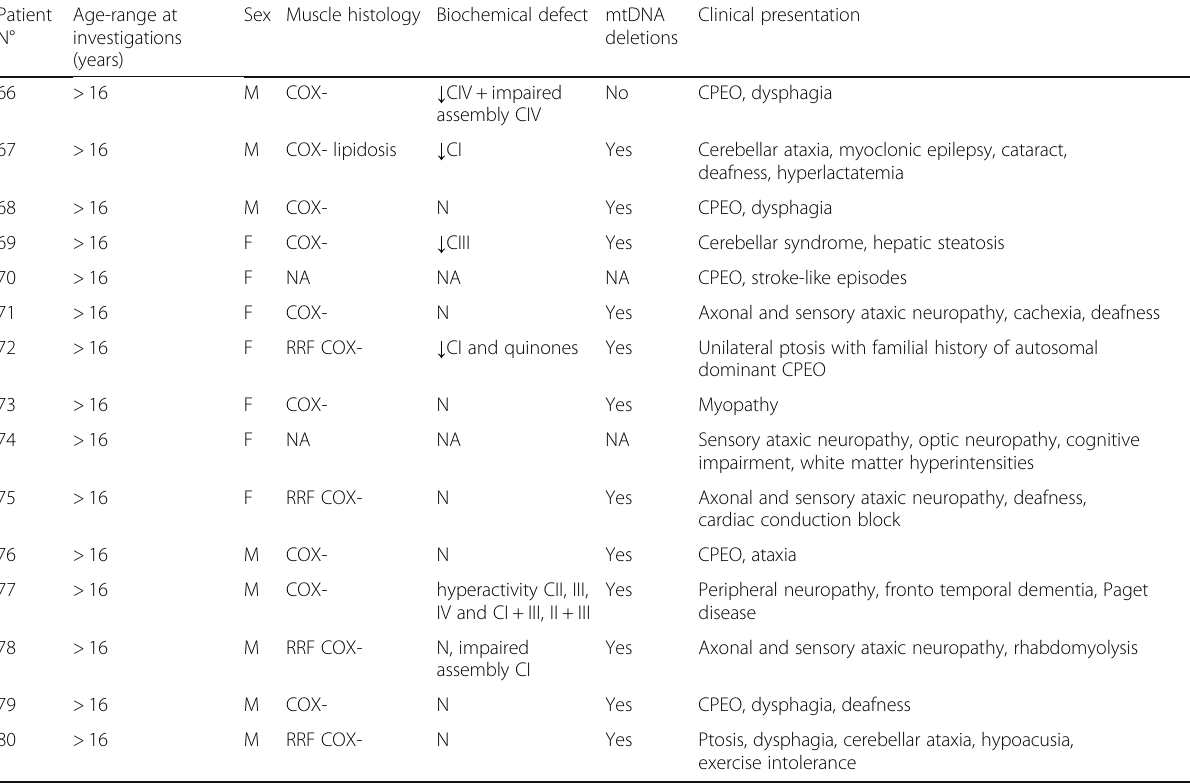
Table 1 List of the patient cohort (Continued) Patient Age-range at N°